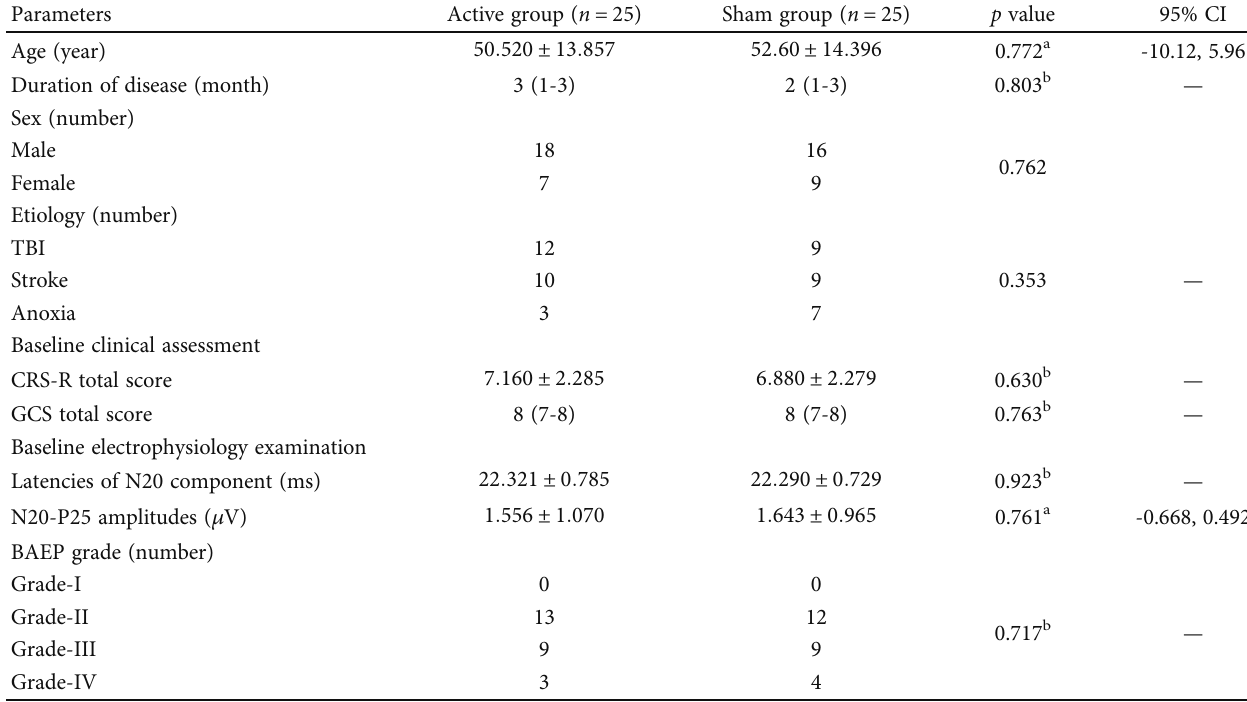
Table 1: Baseline characteristics of the study population.